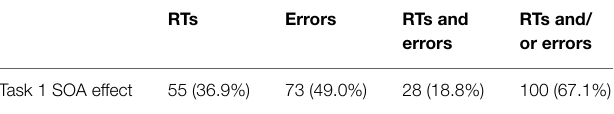
TABLE 3 | Number and percent of experiments (total number experiments is 149) with statistical analyses of RTs and error data (see Table 2) as well as an effect of SOA on Task 1 performance (i.e., decreasing SOA and increasing RTs/error